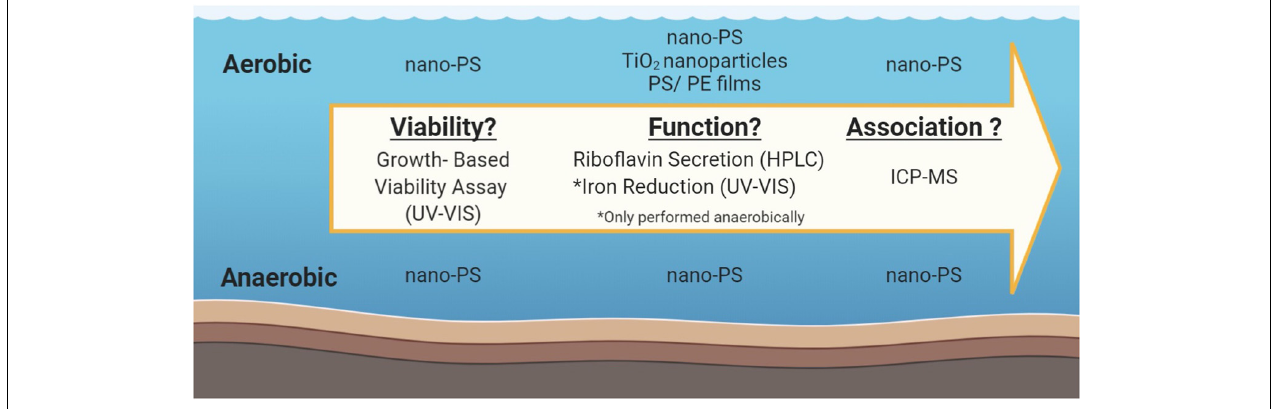
FIGURE 1 | Schematic of experimental workflow, including the exposure materials studied in the various